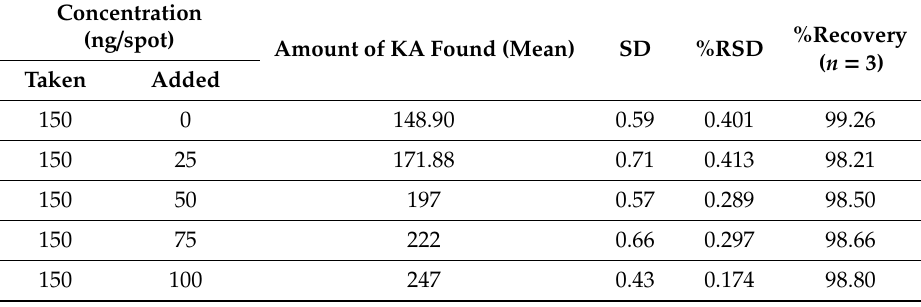
Table 4. Data of accuracy for KA.